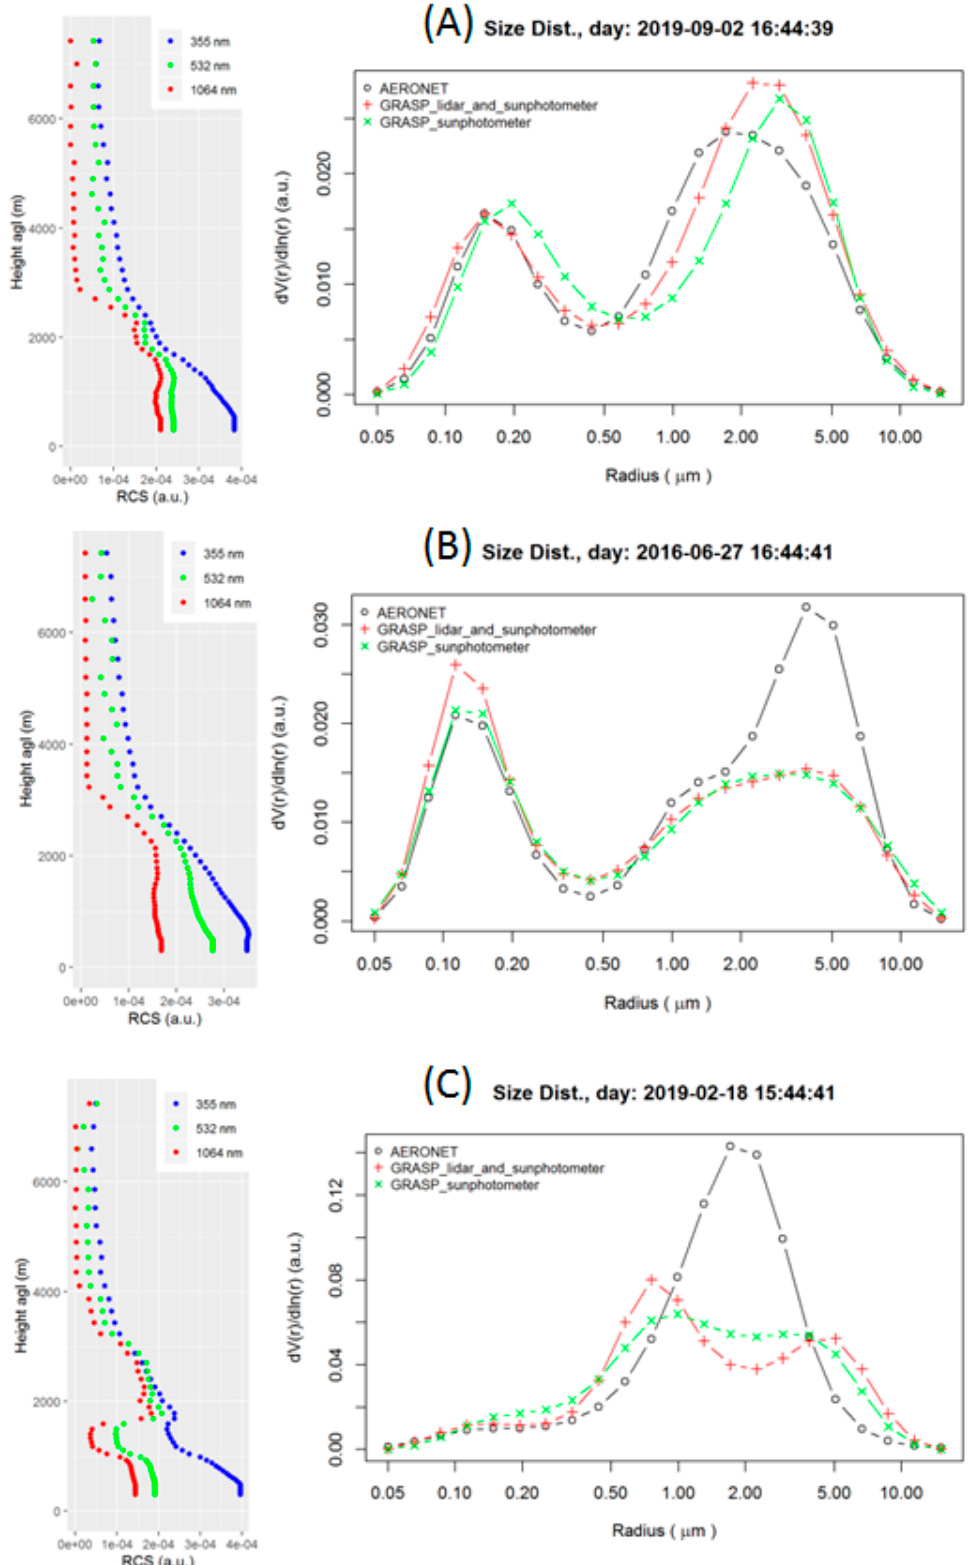
Figure 4. Three selected cases showing (A) good agreement among the VSDs , (B) discrepancy in the coarse mode with AERONET VSD , and (C) dust-rich elevated layer affecting the VSD (bottom panel). Left panels correspond to lidar profiles, right panels are the VSDs.